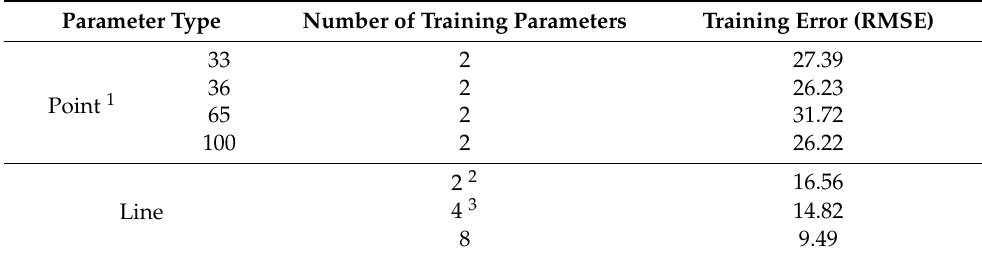
Table 7. Battery SOC estimation